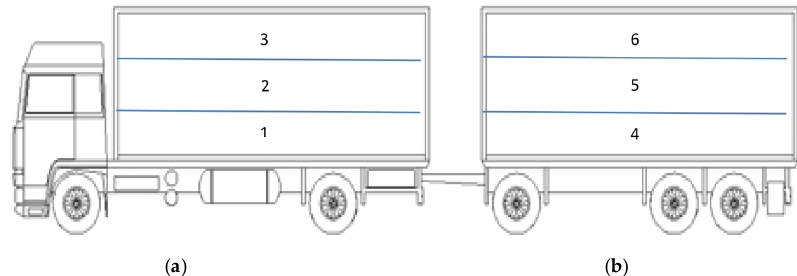
Figure 1. Schematic drawing of the truck with hydraulic decks used for pig transportation. The lorry was always unloaded before the trailer and decks were unloaded sequentially, starting with the lower deck. ( a ) LORRY; ( b ) TRAILER.